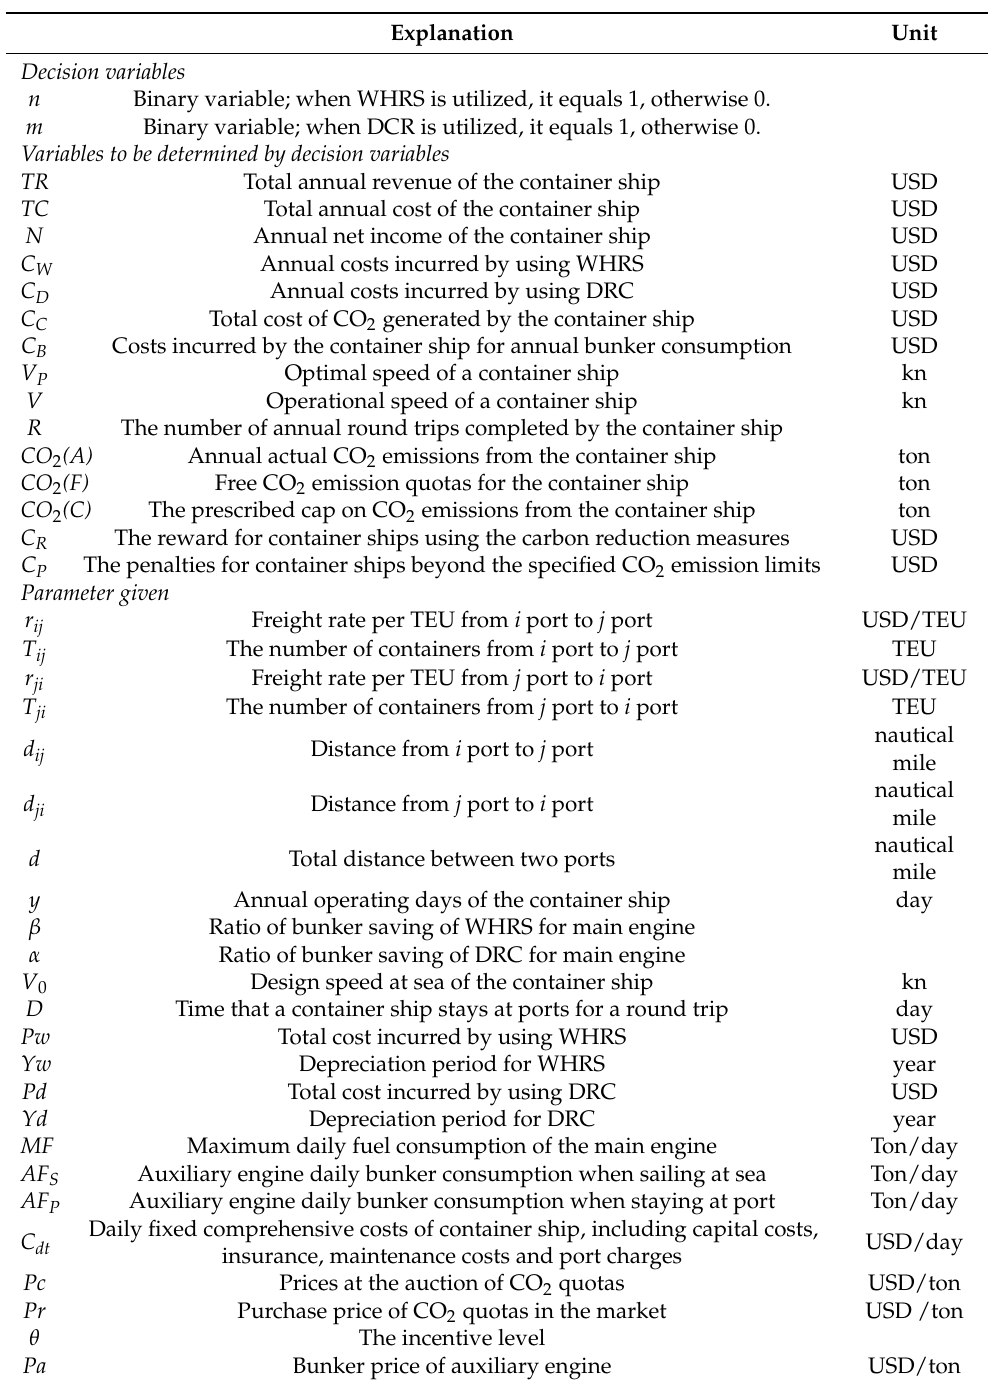
Table 2. Variables and parameters in this model. Explanation Unit Decision